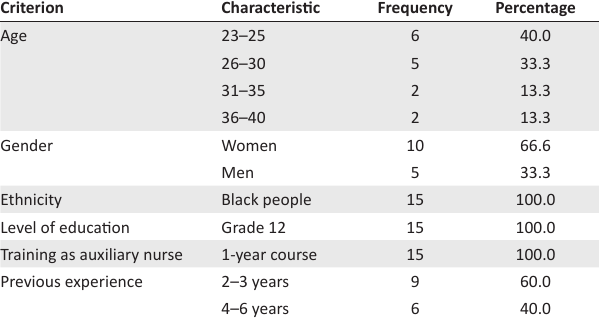
TABLE 1: Demographic profile of the participants.